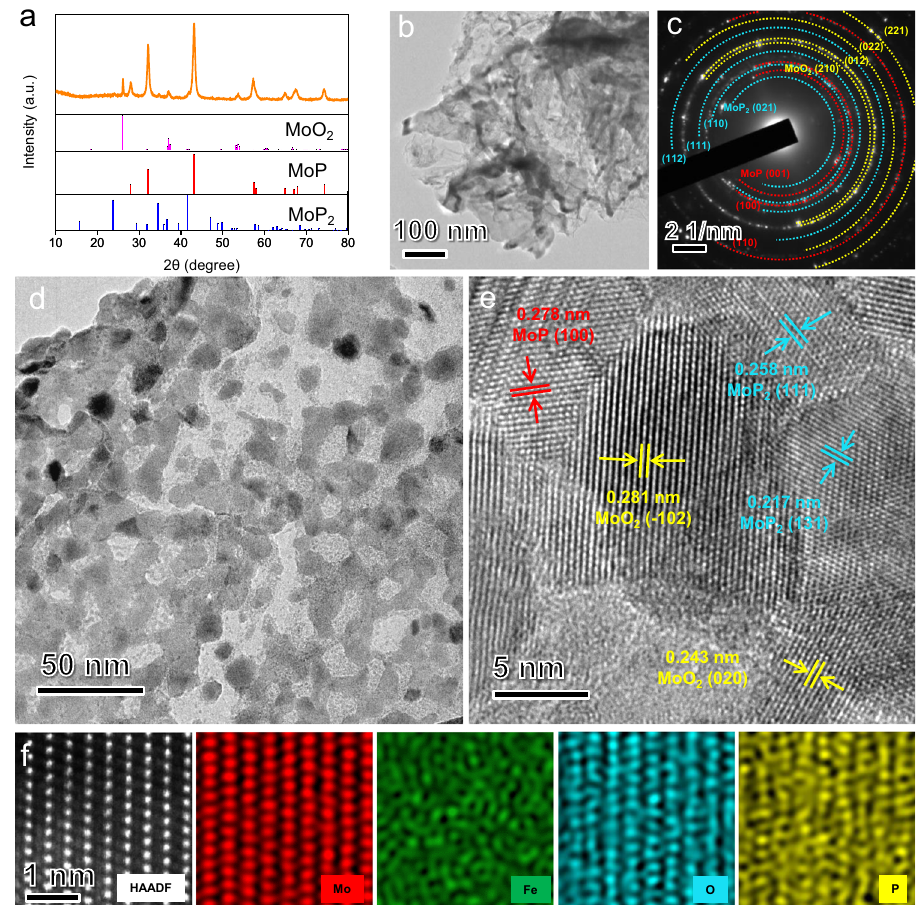
Fig. 2 | Structural characterisation of Fe/SAs@Mo-based-HNSs. a XRD patterns; b low-magni fi cation TEM image, c SAED pattern, d high-magni fi cation TEM image, e HRTEM image, and f HAADF-STEM image and the corresponding EDS elemental mapping of Fe (green), Mo (violet), P (orange) and O